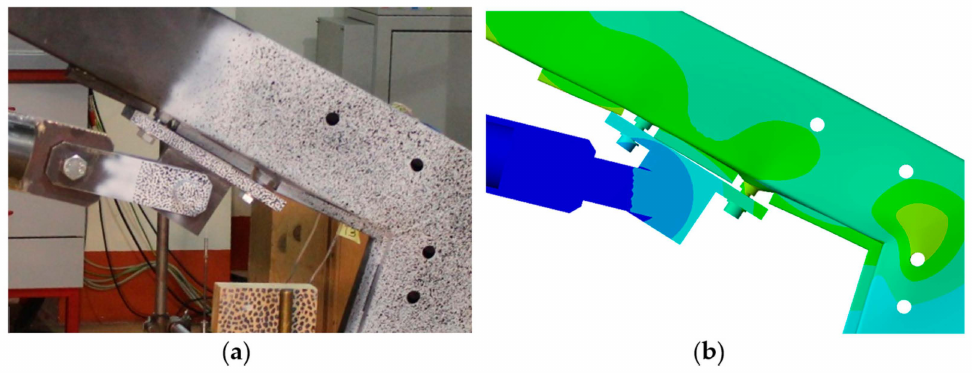
Figure 14. Failure mode comparison between: ( a ) laboratory specimen; ( b ) numerical